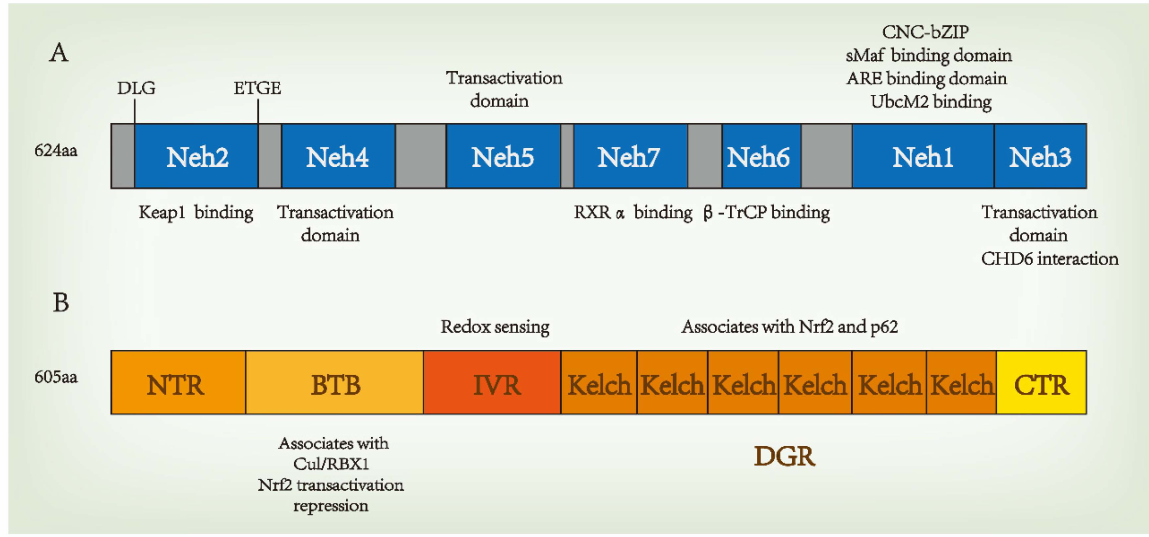
Figure 1. Domain structures of nuclear factor erythroid 2-related factor 2 (Nrf2) ( A ) and Kelch- like-ECH-associated protein 1 (Keap1) ( B ). β -TrCP, a β -transducin repeat-containing protein. CNC, cap‘n’collar; bZIP, basic region leucine zipper; sMafs, musculoaponeurotic fibrosarcoma protein;